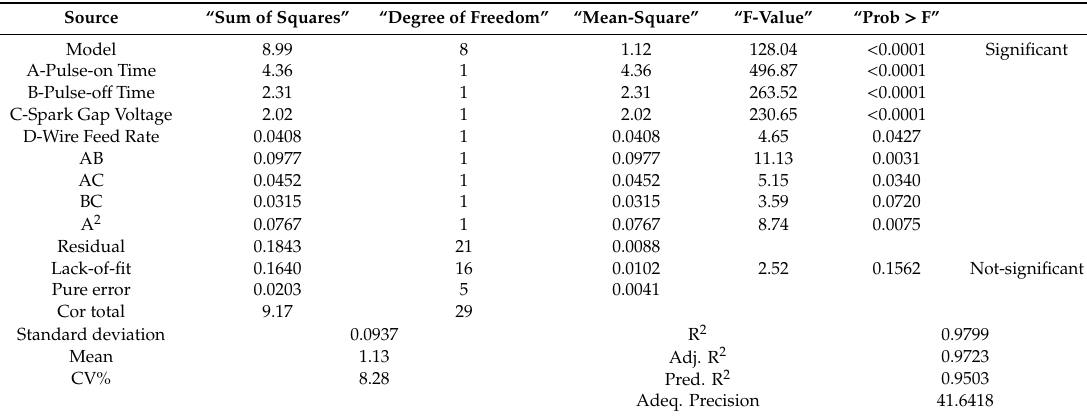
Table 5. Analysis of variance (ANOVA) test results for cutting rate